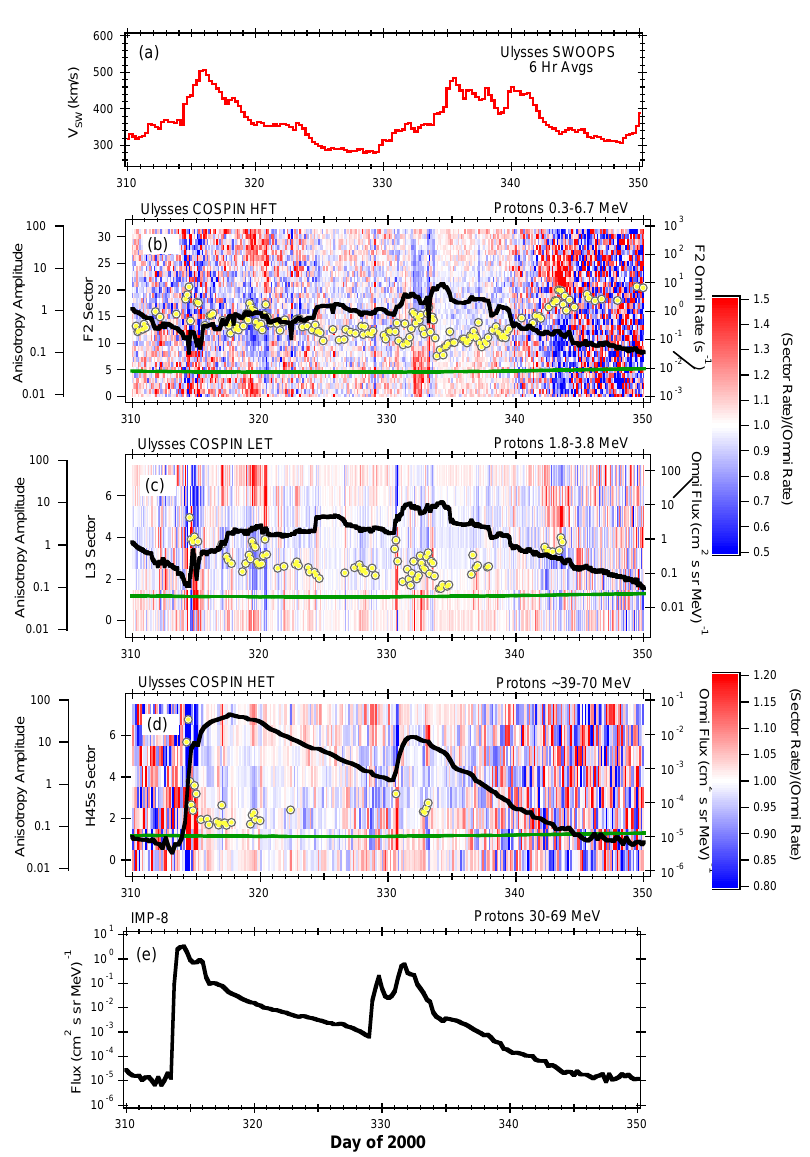
Fig. 4. (a) Solar wind speed observed at Ulysses (b)–(d) Three-hour average intensities or fluxes (black lines, right axes) and ratios of intensities in each spin sector (near-left axes) to omnidirectional average intensities (red and blue shading, corresponding to keys to the right of the panels. Red represents higher intensity relative to the omnidirectional average) for the COSPIN HFT (0.3–6.7MeV protons, panel b), LET (1.8–3.8MeV protons, panel c) and HET (39–90MeV protons, panel d) spin-sectored counting rates. The HFT divides each spacecraft spin into 32 sectors, while the LET and HET both have only 8 sectors. The green line indicates the computed direction of maximum (red) expected for particles propagating outward along an ideal 400km/s Parker spiral field line. The yellow dots (leftmost axis) represent the anisotropy amplitudes, defined as ((max flux)/(min flux) − 1), for periods when an isotropic flux distribution could be rejected at 95% confidence by a chi-square test. (e) Simultaneously measured flux of 30–69MeV protons measured at